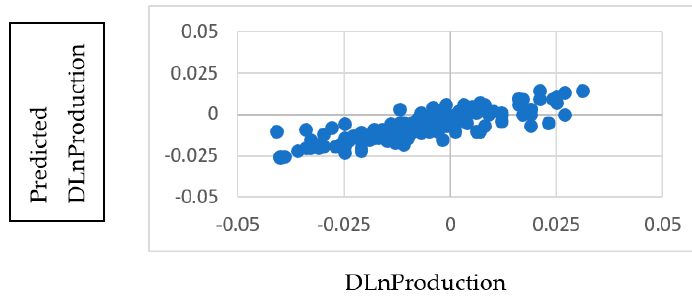
Figure 2. Actual vs. predicted target values.